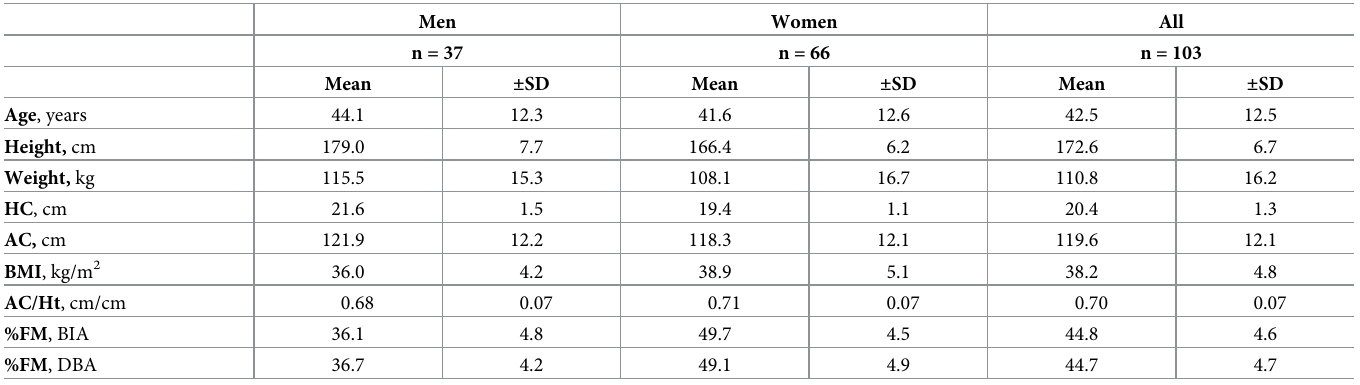
Table 2. Anthropometric and body composition characteristics of obese Europid adults (Mean ±